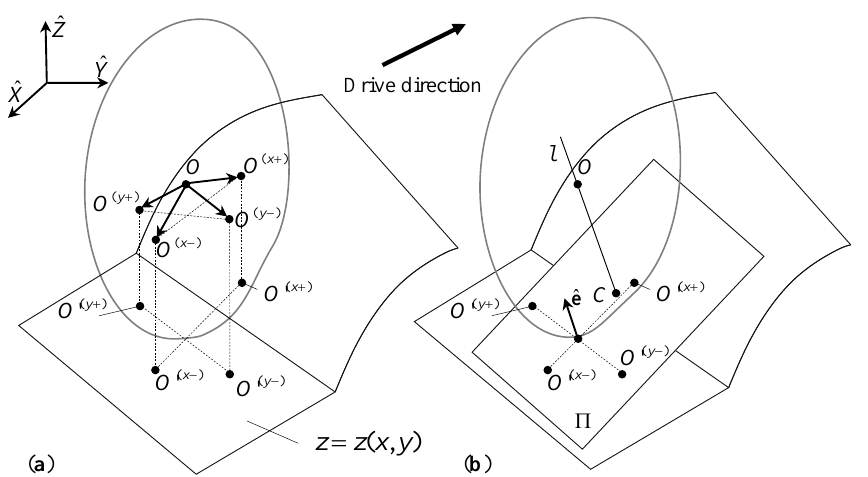
Figure 3. A way of determining the contact point position in a precise way. ( a ) Stage 1—selecting the control points; ( b ) stage 2—determining contact point 𝐶 .